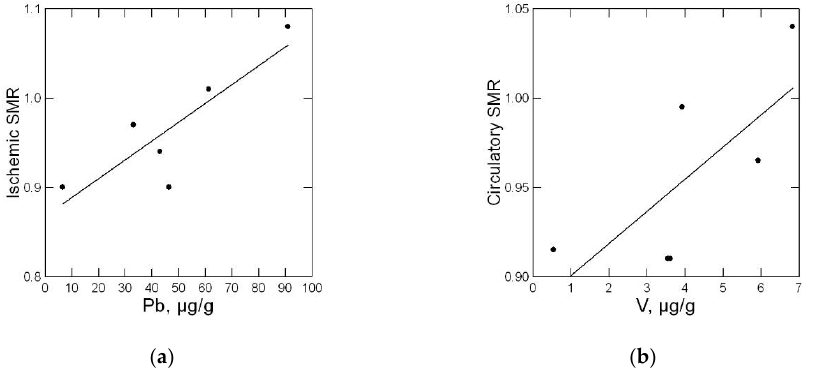
Figure 3. Correlation between the element concentrations and the cause-specific mortality in six Socio Health Districts: ( a ) the relationship between the median value of the Pb concentration (as µg/g) measured in the samples of tree bark and the ischemic standardized mortality ratio (SMR) ( r = 0.853; p = 0.031); ( b ) the relationship between the median value of the V concentration (as µg/g) measured in the samples of tree bark and the SMR from circulatory diseases ( r = 0.731; p = 0.099). These findings are in agreement with previous studies [24] highlighting that Pb was the element with the greatest enrichment factor in the UAs of Genoa, with concentrations which are seven times higher with respect to that in the small town. Moreover, shipping emissions are responsible for high atmospheric levels of V in important port cities [38,39]. In Genoa, the maritime traffic takes place mainly in the western part of the city, characterized by V concentrations twice that in the eastern part. A correlation between the level of V in atmospheric PM and cardiovascular hospitalization was found in several studies [40,41].